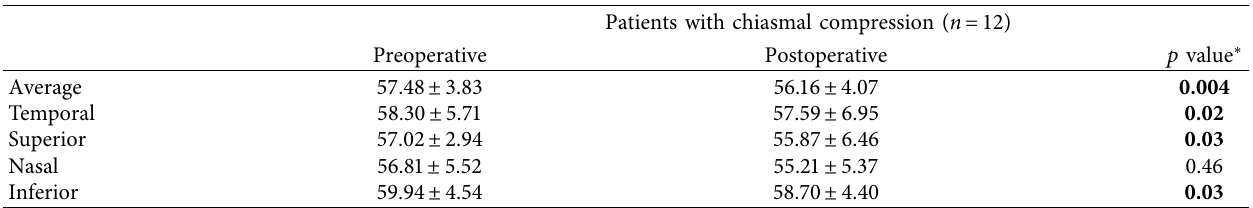
Table 4: Pre- and postoperative vessel density comparison of patients with chiasmal compression with and without optic